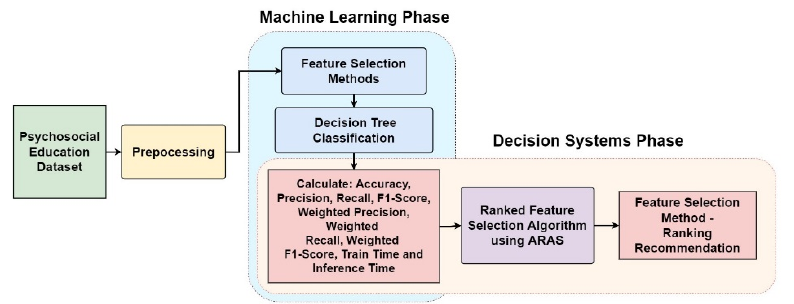
Figure 1. The proposed method of decision model to evaluate feature selection